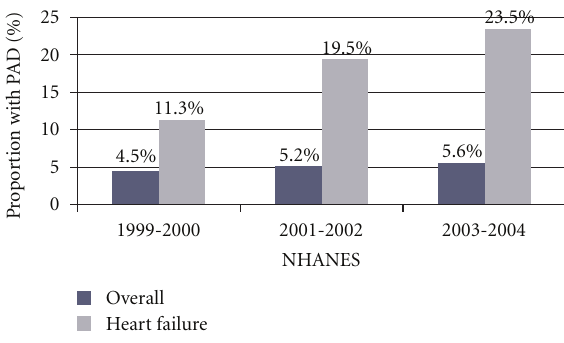
Figure 2: Weighted prevalence of PAD for each survey period.